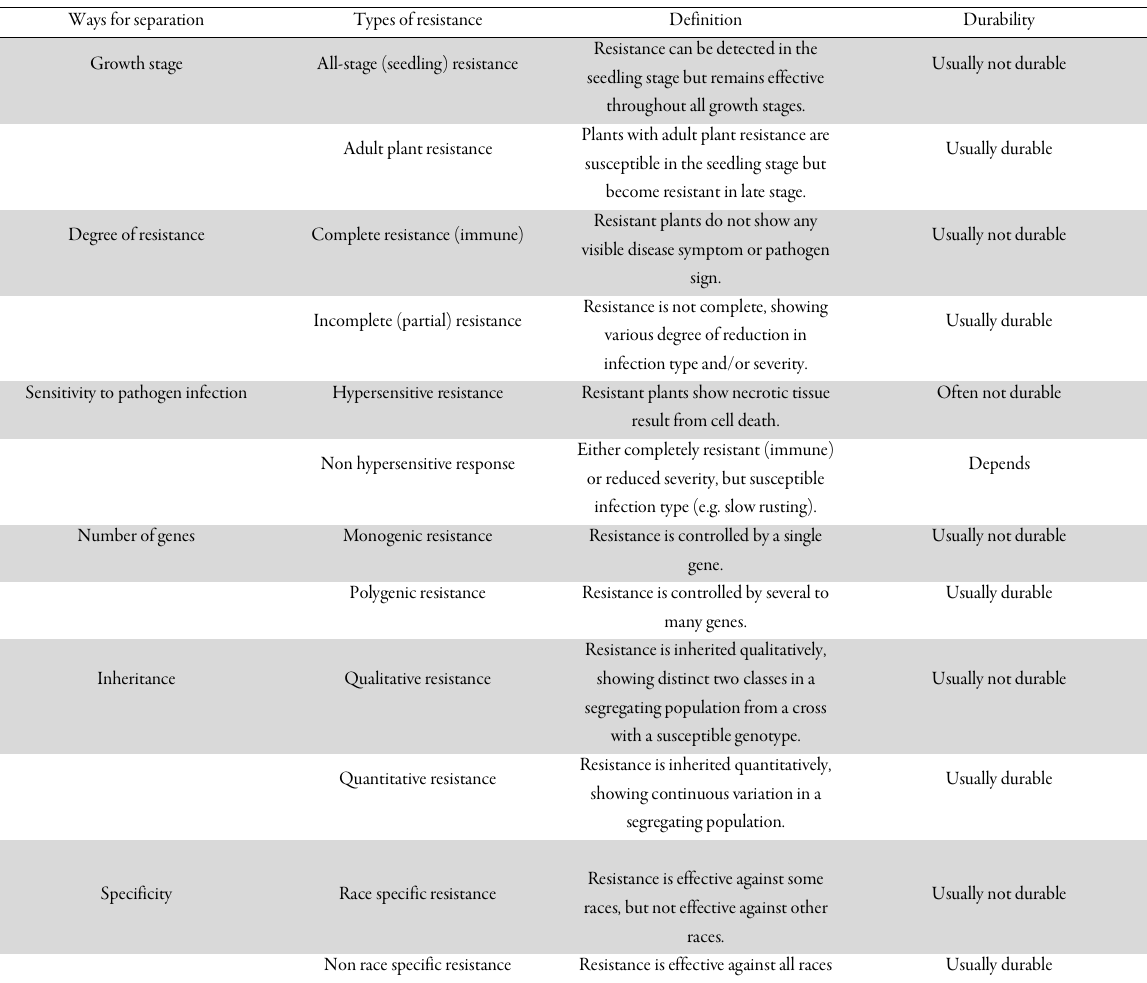
Table 1.Types of resistance to stripe rust based on various ways of separation with modifications (Chen, 2013) Ways for